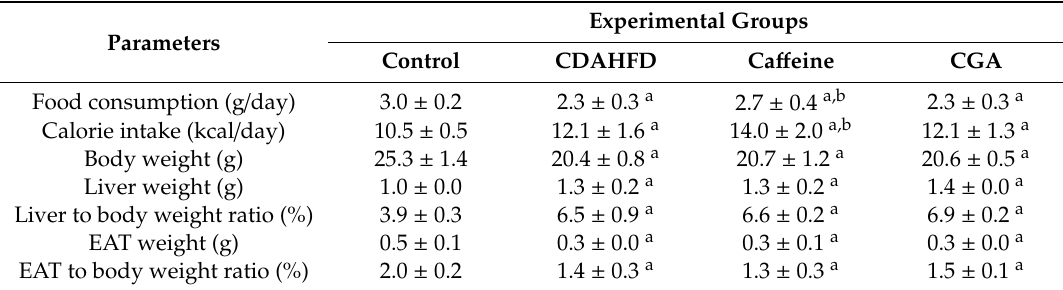
Table 2. Food consumption, calorie intake, and body and organ